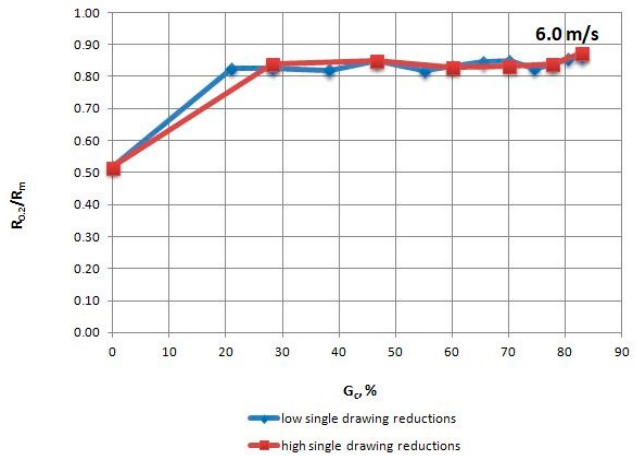
Figure 7. Change of the R 0.2 / R m coe ffi cient of TRIP steel wires for variants with low and high single drawing reductions, at a speed of 6.0 m / s, as the total drawing reduction function.